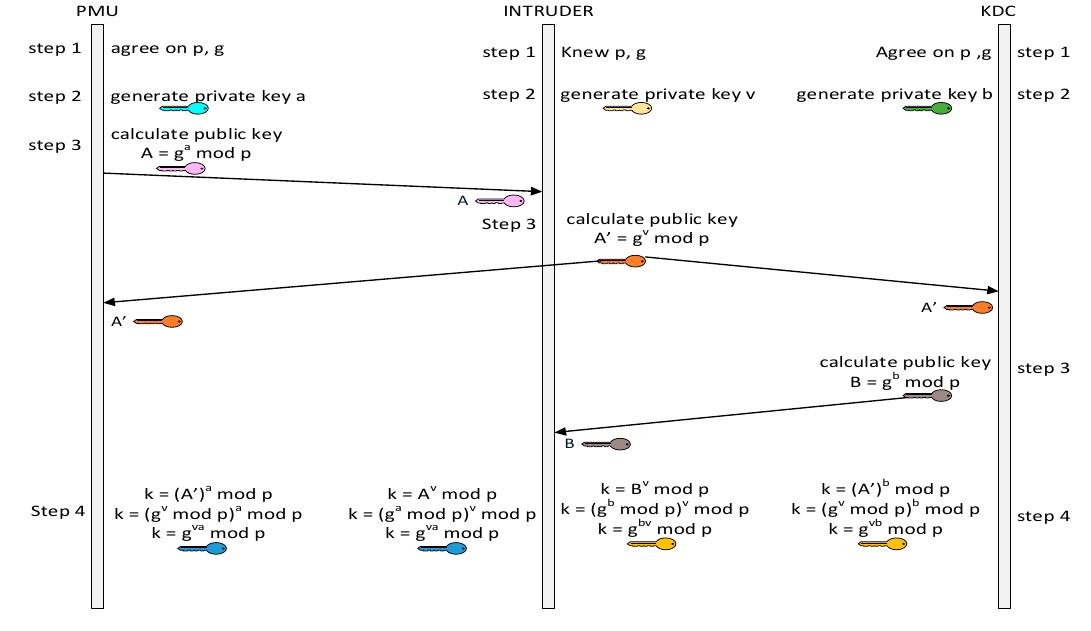
Figure 7. Intruder attempt of the MITM attack.